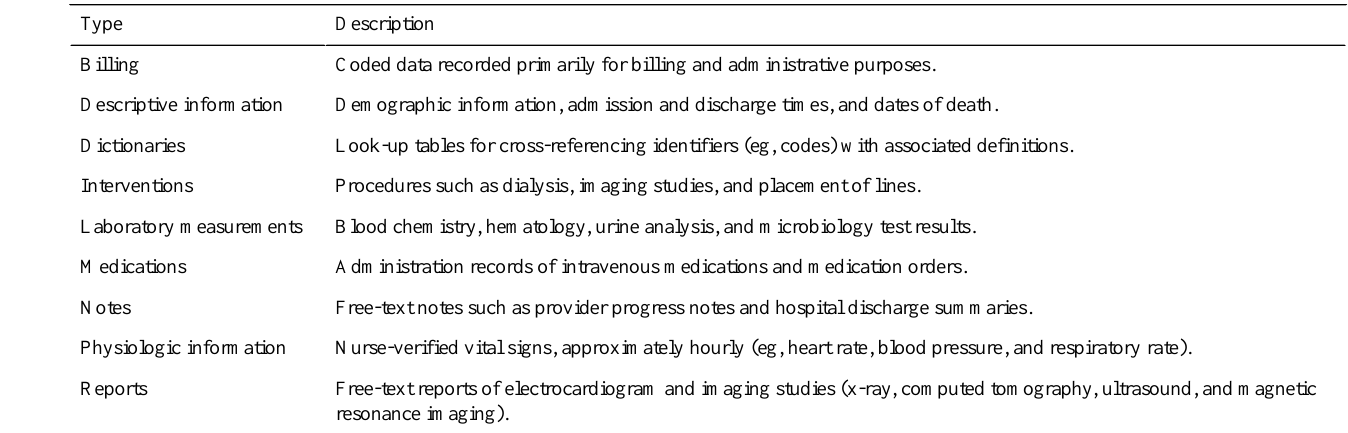
Table 3. Description of clinical data types in the Medical Information Mart for Intensive Care.